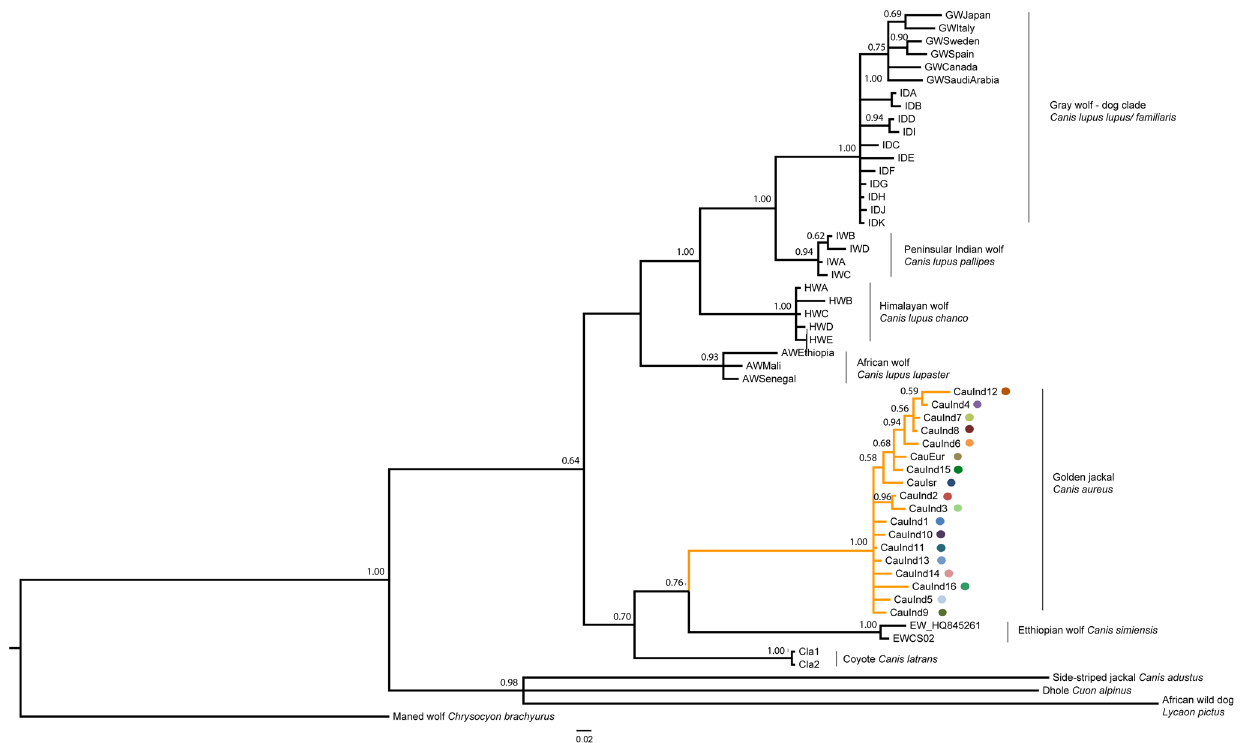
Fig 2. Bayesian phylogenetic relationships of the golden jackal clade based on concatenated cyt b (332 bp) and CR (277 bp) DNA sequences. Values at nodes correspond to posterior probabilities > 0.50. Scale bar represents 2% sequence divergence.